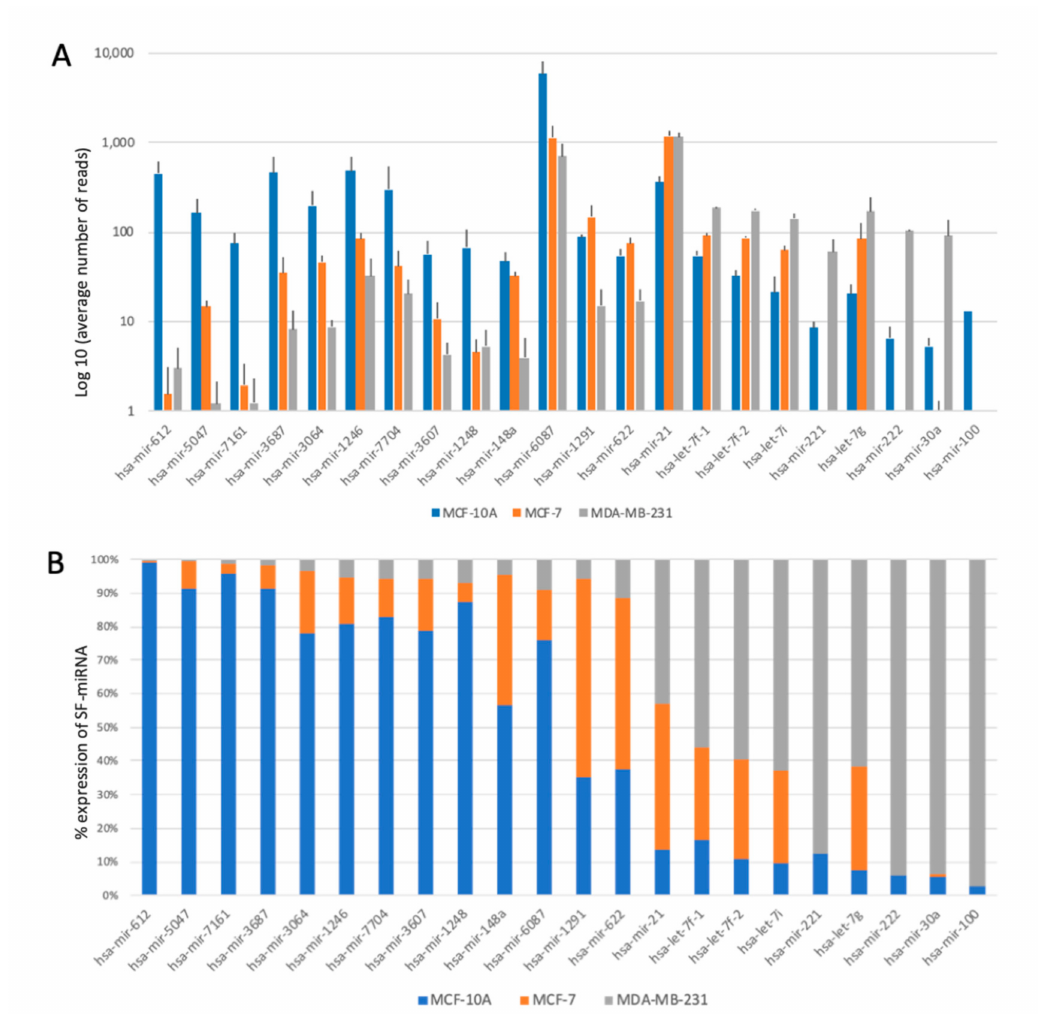
Figure 7. Changes in the expression of top SF-miRNAs with breast cancer tumorigenicity. ( A ) Changes in the expression level of the top 22 SF-miRNAs in the breast-originated cell-lines (log scale). ( B ) The partitions for each miRNA within the three cell-lines is shown. MCF-10A (blue), MCF-7 (orange), and MDA-MB-231 (grey). The data source is in Supplemental Table